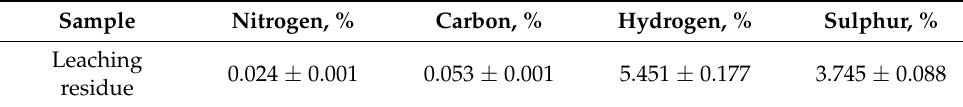
Table 4. Results of elemental analysis of leaching residue.